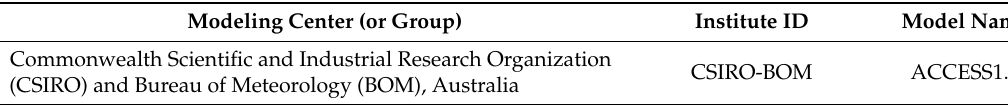
Table 1. CMIP5 models utilized for this study (Reclamation